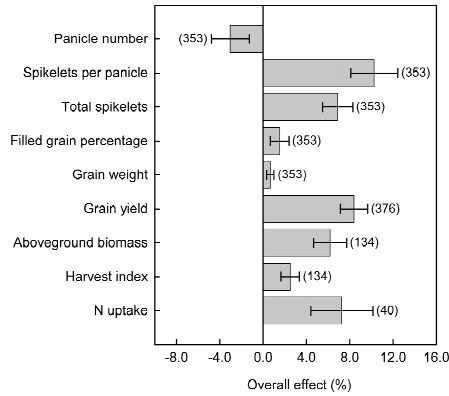
Figure 2. Effects of potted-seedling machine transplantation on panicle number, spikelets per panicle, total spikelets, filled grain percentage, grain weight, grain yield, aboveground biomass, harvest index, and nitrogen (N) uptake in rice paddies. The numbers near the error bars denote the number of observations for each variable. Error bars represent 95% confidence intervals. The grain yield, total spikelets, filled grain percentage, and harvest index of hybrid rice (+10.2%, +7.9%, +1.9%, and +4.0%, respectively) were greater than those of inbred rice (+6.9%, +6.0%, +1.2%, and +1.2%, respectively) (Figure 3), whereas no significant differ- ences were observed in panicle number, spikelets per panicle, grain weight, aboveground biomass, or N uptake (Figure S5). Figure 3. Effects of potted-seedling machine transplantation (PSMT) on grain yield ( a ), total spike- lets ( b ), filled grain percentage ( c ), and harvest index ( d ) as affected by rice types in paddies. The numbers near the error bars denote the number of observations for each variable. Error bars repre- sent 95% confidence intervals, and p values indicate the results of a Wald-type test for differences between classes. 3.2. Grain Quality On average, compared to BSMT, PSMT increased the brown rice rate (+0.74%), milled rice rate (+1.1%), head rice rate (+2.3%), and gel consistency (+4.4%) while reducing the amylose content ( − 3.7%), with no significant effects on the chalky grain rate, chalkiness, length/width ratio, or protein content (Figure 4).